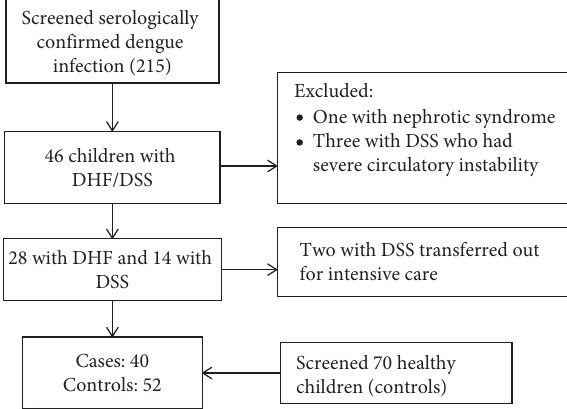
Figure 1: Algorithm for subject enrolment during the study